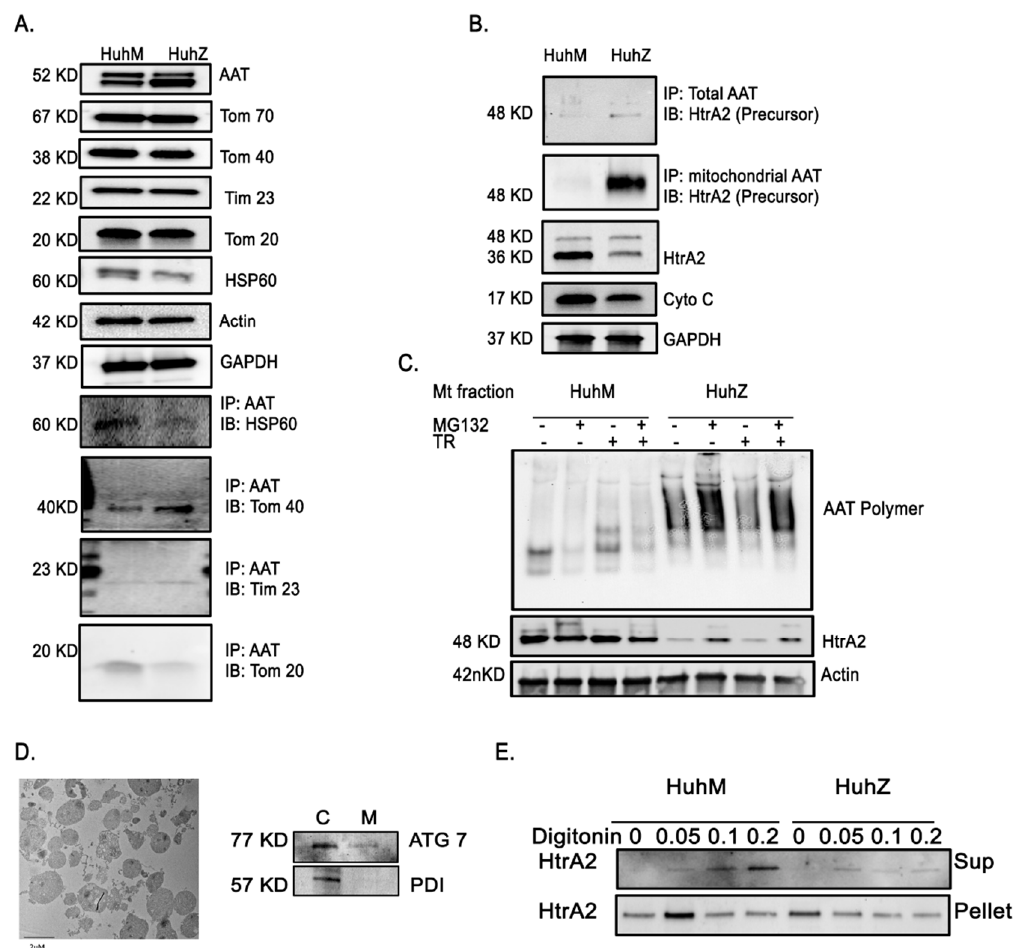
Figure 6. Mitochondrial interaction of AAT and HtrA2. ( A ) Detection of AAT translocation to the mitochondria through mitochondrial import machinery using co-immunoprecipitation analysis from total cell lysate, showing both MAAT and ZAAT interaction with Tom40, Tom20, and Tim23 in Huh7.5 cells. ( B ) Co-immunoprecipitation analysis from total Huh7.5 cell lysate, indicating mitochondrial ZAAT interaction with mitochondrial HtrA2. ZAAT interacts with the full-length precursor form of HtrA2. ( C ) The aggregation status of mitochondrial AAT and HtrA2 in the mitochondrial fraction of MAAT- and ZAAT-expressing Huh7.5 cells using proteasome inhibitor MG132 and trypsin. Actin was loaded as loading control. ( D ) Electron microscopy showing mitochondrial fraction purity and Western blot analysis of peroxisomal ATG7 and ER-associated chaperone PDI in cytoplasmic (C) and mitochondrial fraction (M), respectively. ( E ) Western blot analysis showing the mitochondrial release of HtrA2 in presence of different concentrations of digitonin form MAAT- and ZAAT-expressing hepatocytes.